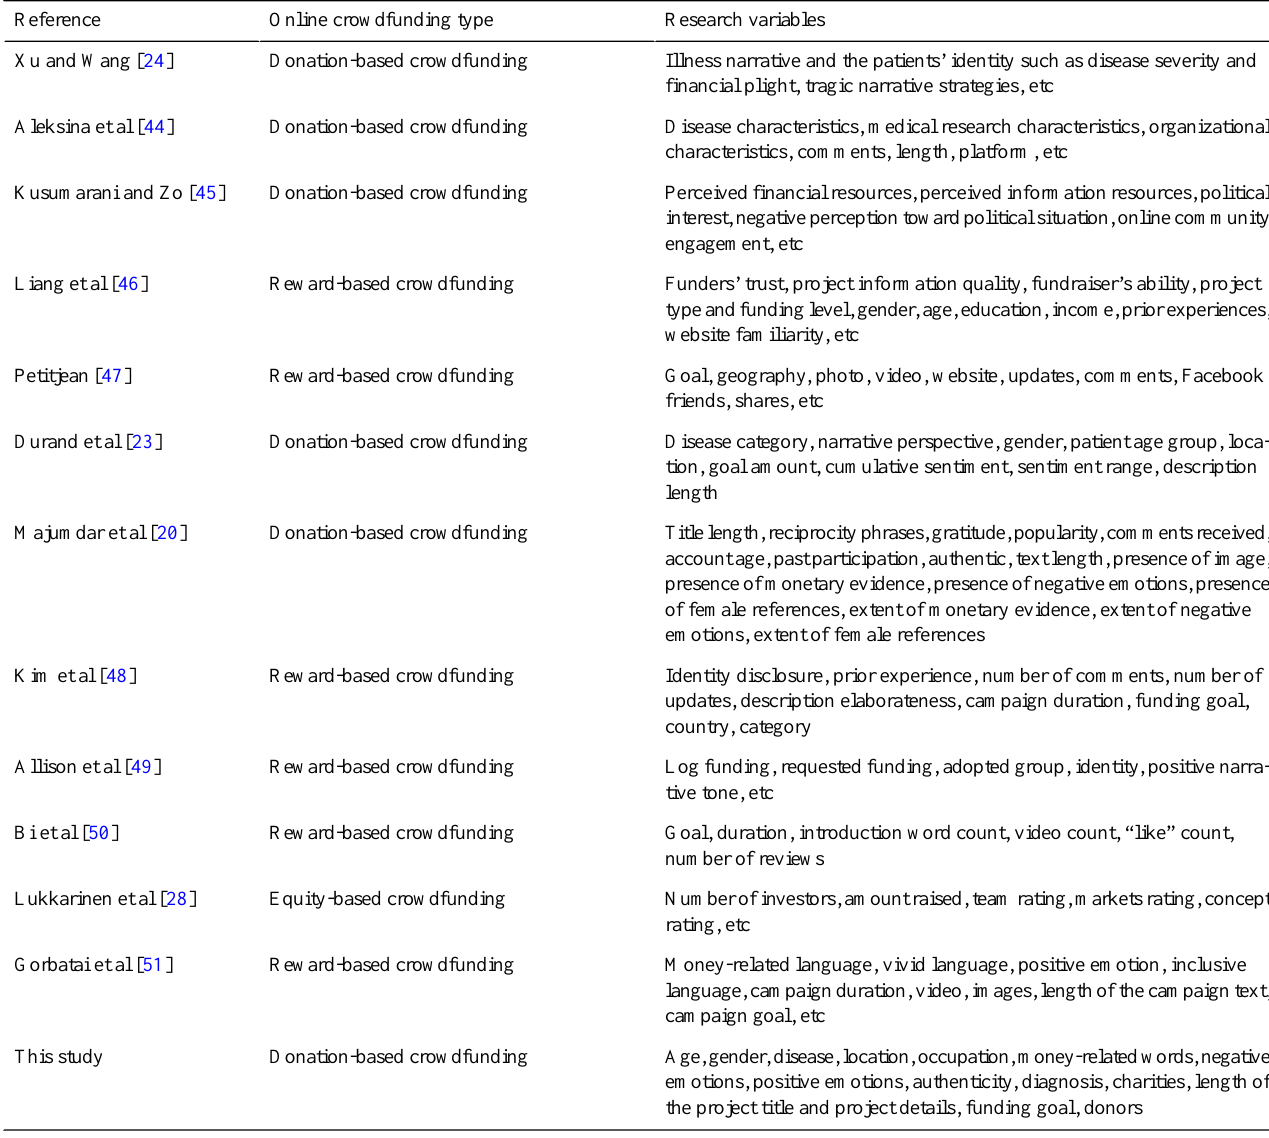
Table 1. Textual features affecting the success rate of online crowdfunding projects. etcDonation-based crowdfundingXu and Wang [24]